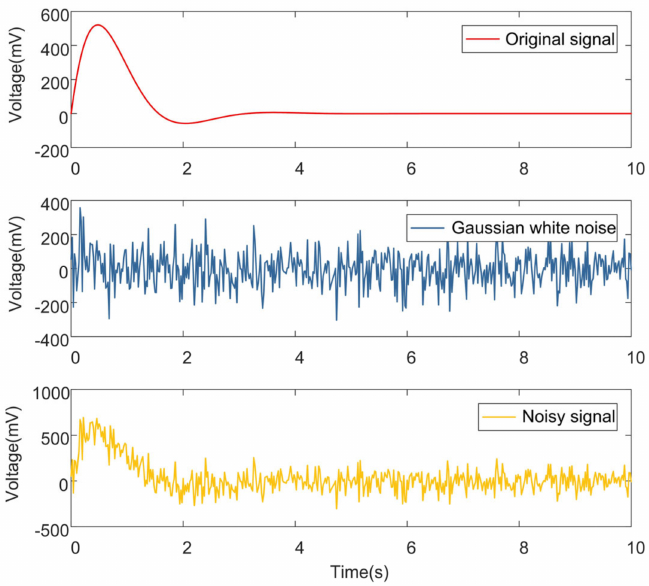
Figure 6. Time domain signal diagram of the simulated